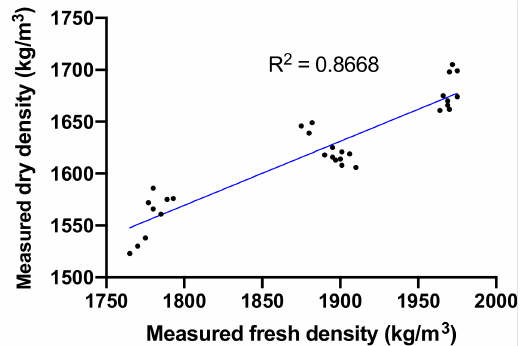
Figure 16. Measured dry density versus measured fresh density of backfill specimens.